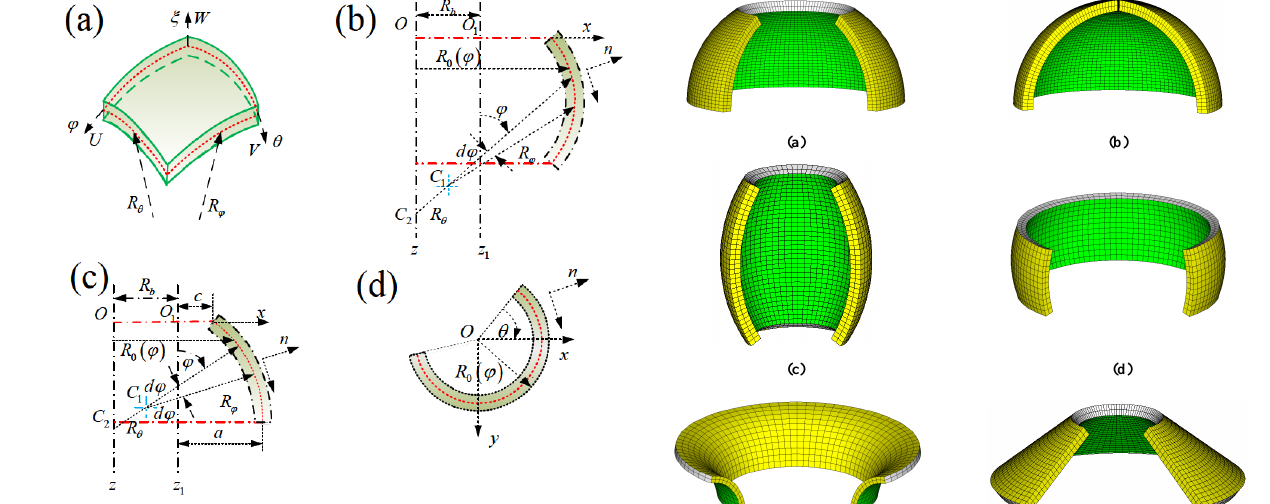
Figure 1: The geometric parameters and coordinate system of a FG shell: (a) the differential element of the FG shell; (b) the spherical shell coordinate system; (c) the parabolic shell coordinate system; (d) circumferential section of the FG shell.